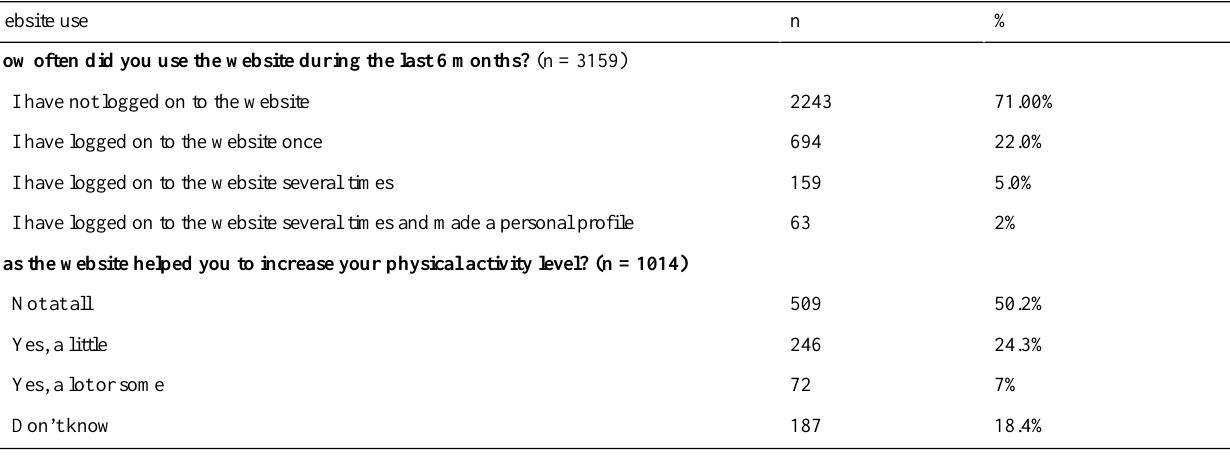
Table 6. Use of the intervention website at 6-month follow-up in the website group (Denmark, 2008) a . %nWebsite